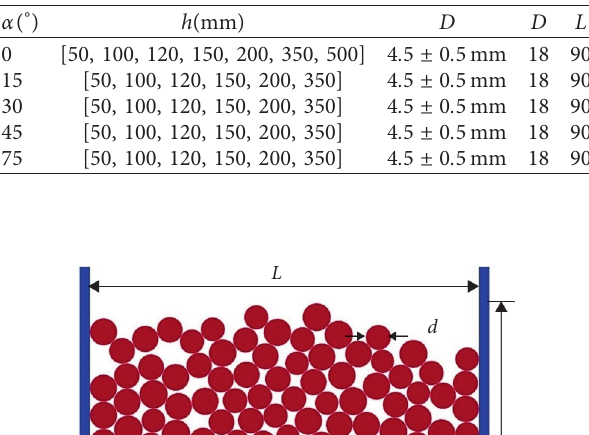
Figure 1: A picture of the experimental system when clogging occurs. Table 1: Test facility dimensions and parameters.